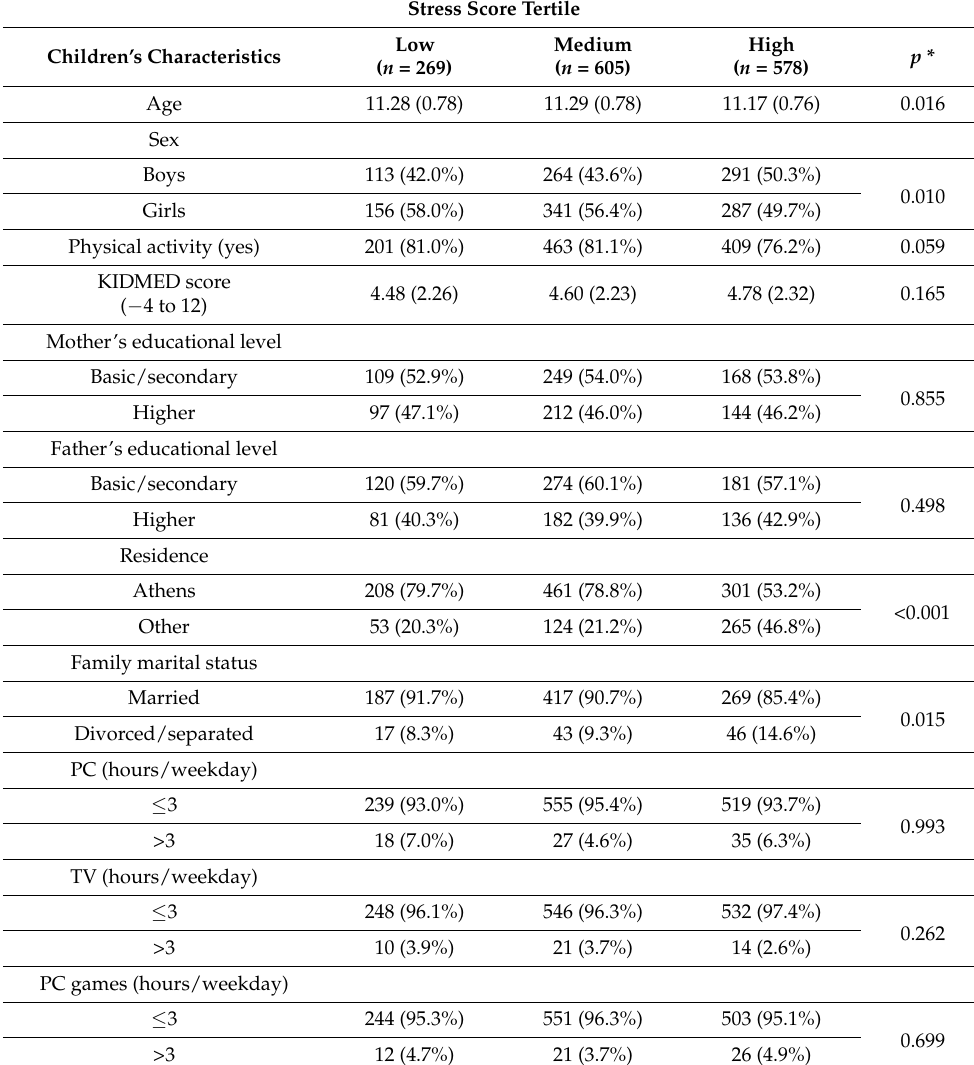
Table 3. Children’s sociodemographic characteristics and lifestyle habits, by stress